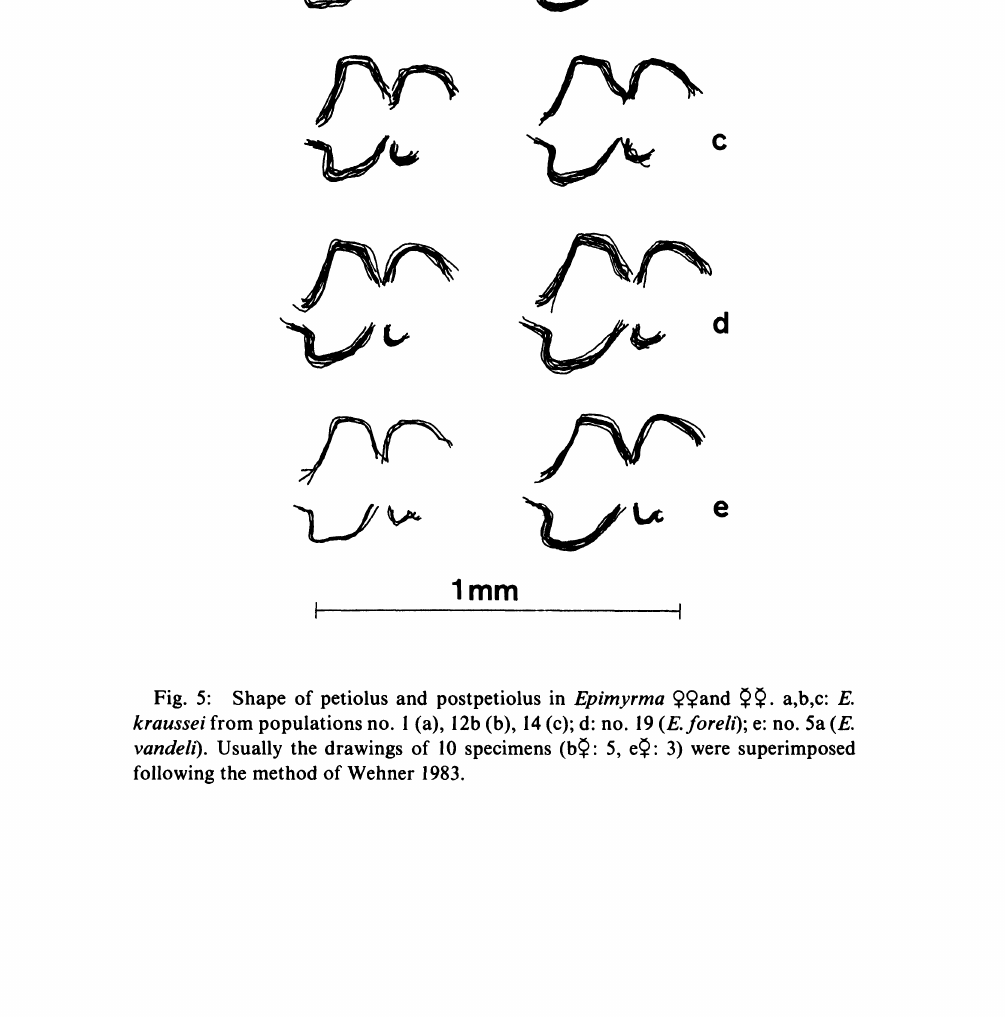
. a,b,c: E. e: 3) were superimposed